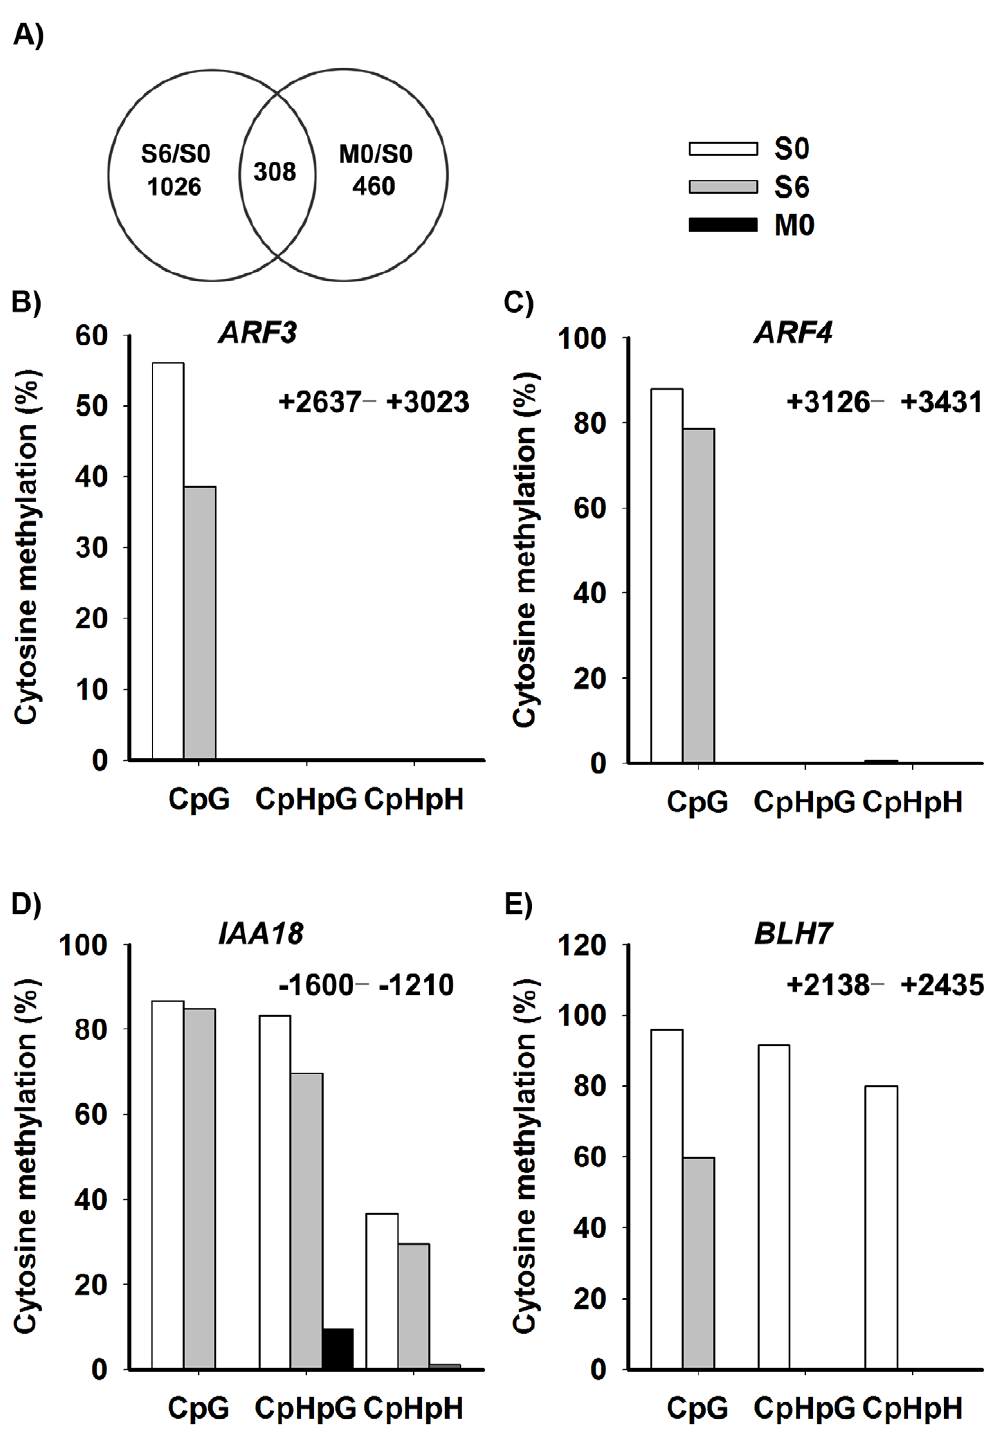
Figure 6. Identification of the candidate genes regulated by DNA methylation. A) The overlap between differentially-expressed genes of S6 versus S0 (Table S3) and M0 versus S0 (Table S4) were identified as candidate genes, and were listed in Table S5. A two-fold difference in the expression level of genes with a q value # 0.05 between S6 versus S0 and M0 versus S0 was set as the threshold for the selection of differentially- expressed genes. B)–E) Cytosine methylation levels of ARF3 , ARF4 , IAA18 and BLH7 genes in calli of wild type (S0, S6), and calli of met1 (M0) were determined by bisulfite genomic sequencing. H represents A, T or C. doi:10.1371/journal.pgen.1002243.g006 novo shoot regeneration. In mammals, epigenetic modifications of organogenesis [51,52]. Our results thus provide an interesting transcription factors and of components in hormone signaling scenario in which epigenetic modifications were adopted as pathways also play crucial roles in cell differentiation and recurring themes during evolution for de novo organogenesis.